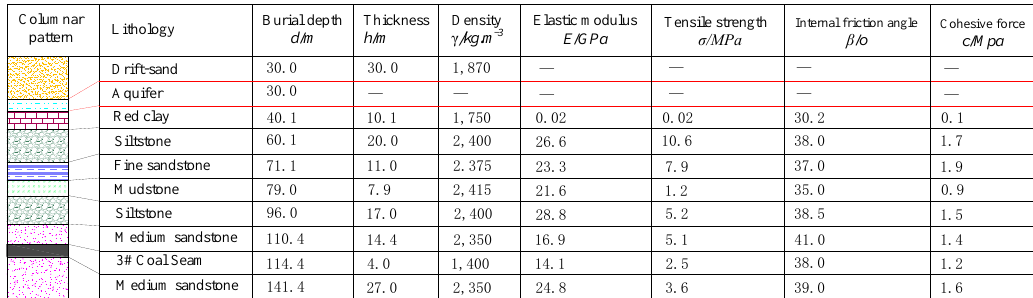
Figure 9. Arrangement of the working face in SBM. 4.2. Development of HWFZ According to the specific parameters of the project as shown in Figure 8, the key strata was first identified [24]. The silt-sandstone layer (at a depth of 17.0 m) was the inferior key stratum, while the silt-sandstone layer at a depth of 20.0 m was the key stratum. Based on the previous experiments, the stress concentration coefficient was set in the range, i.e., j = ~1–3. Table 1 lists the specific calculation scheme. When two blocks were recovered, water diversion heights under different mining depths, block lengths, and protection pillar widths were calculated, and the results are shown in Figure 10.